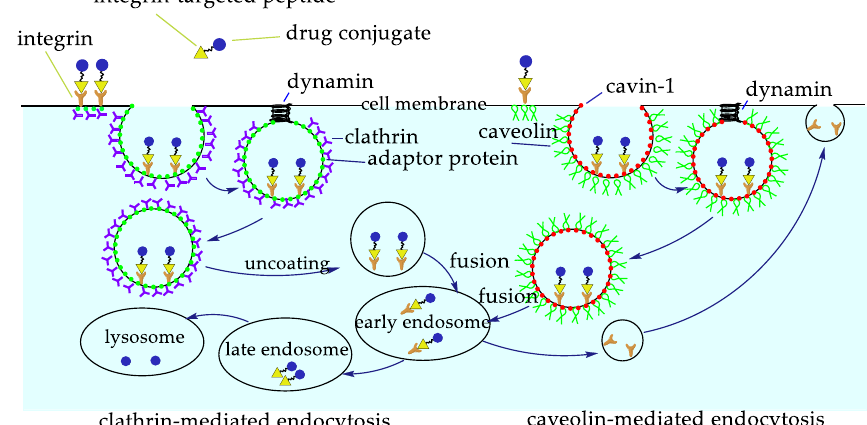
Figure 5. Integrin-targeted internalization of the Arg–Gly–Asp (RGD) peptide-drug conjugates via clathrin or caveolin mediated endocytosis.